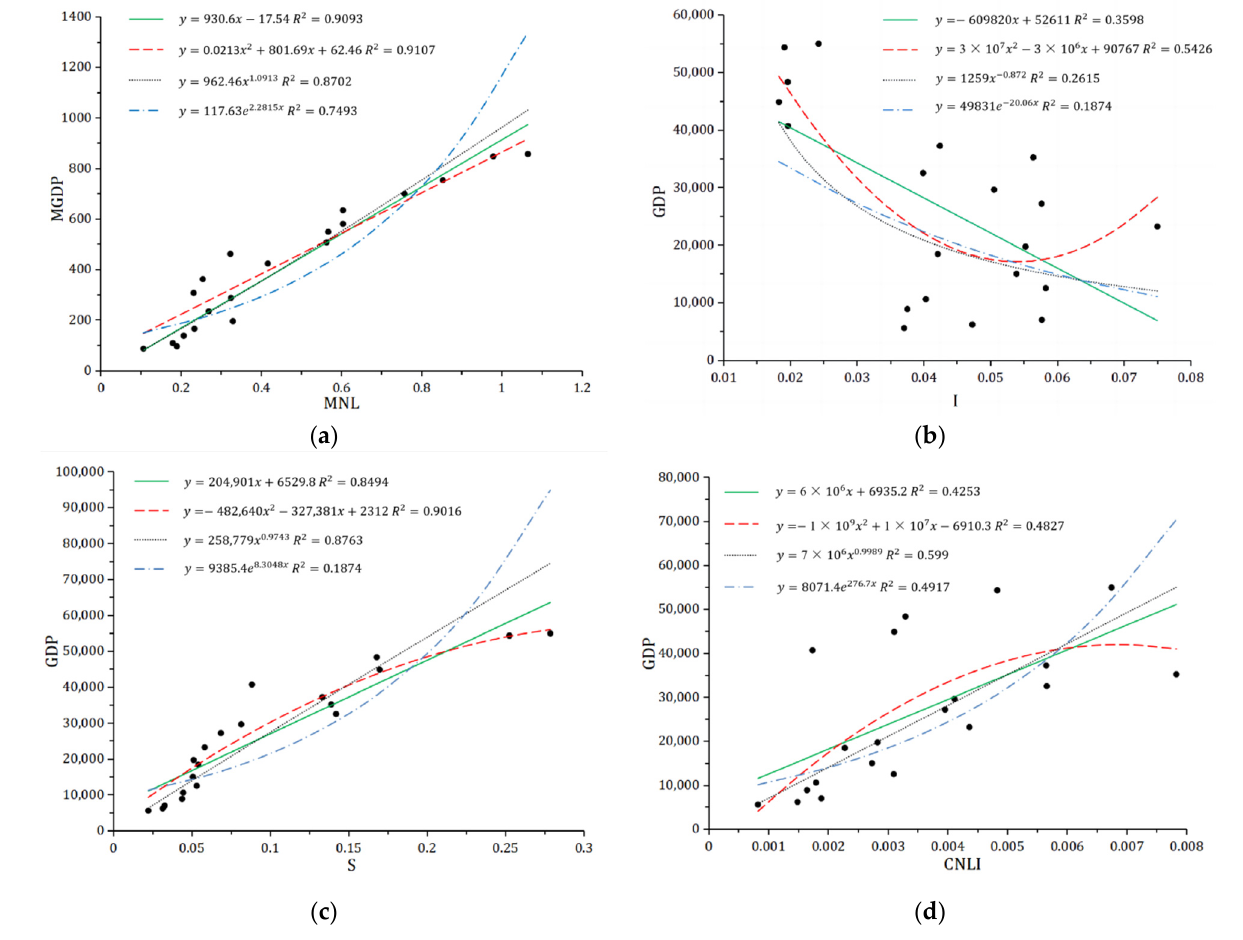
Figure 7. Regression models of the NTL indices and GDP parameters: ( a ) MNL and MGDP, ( b ) I and GDP, ( c ) S and GDP, and ( d ) CNLI and MGDP.